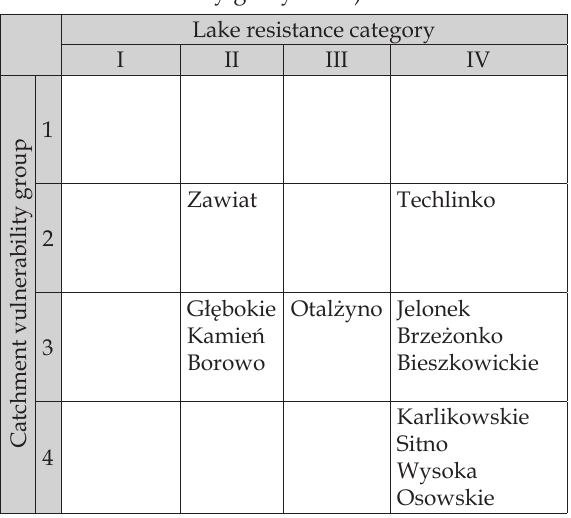
Table 5. Types of lake geoecosystems (lake elementa